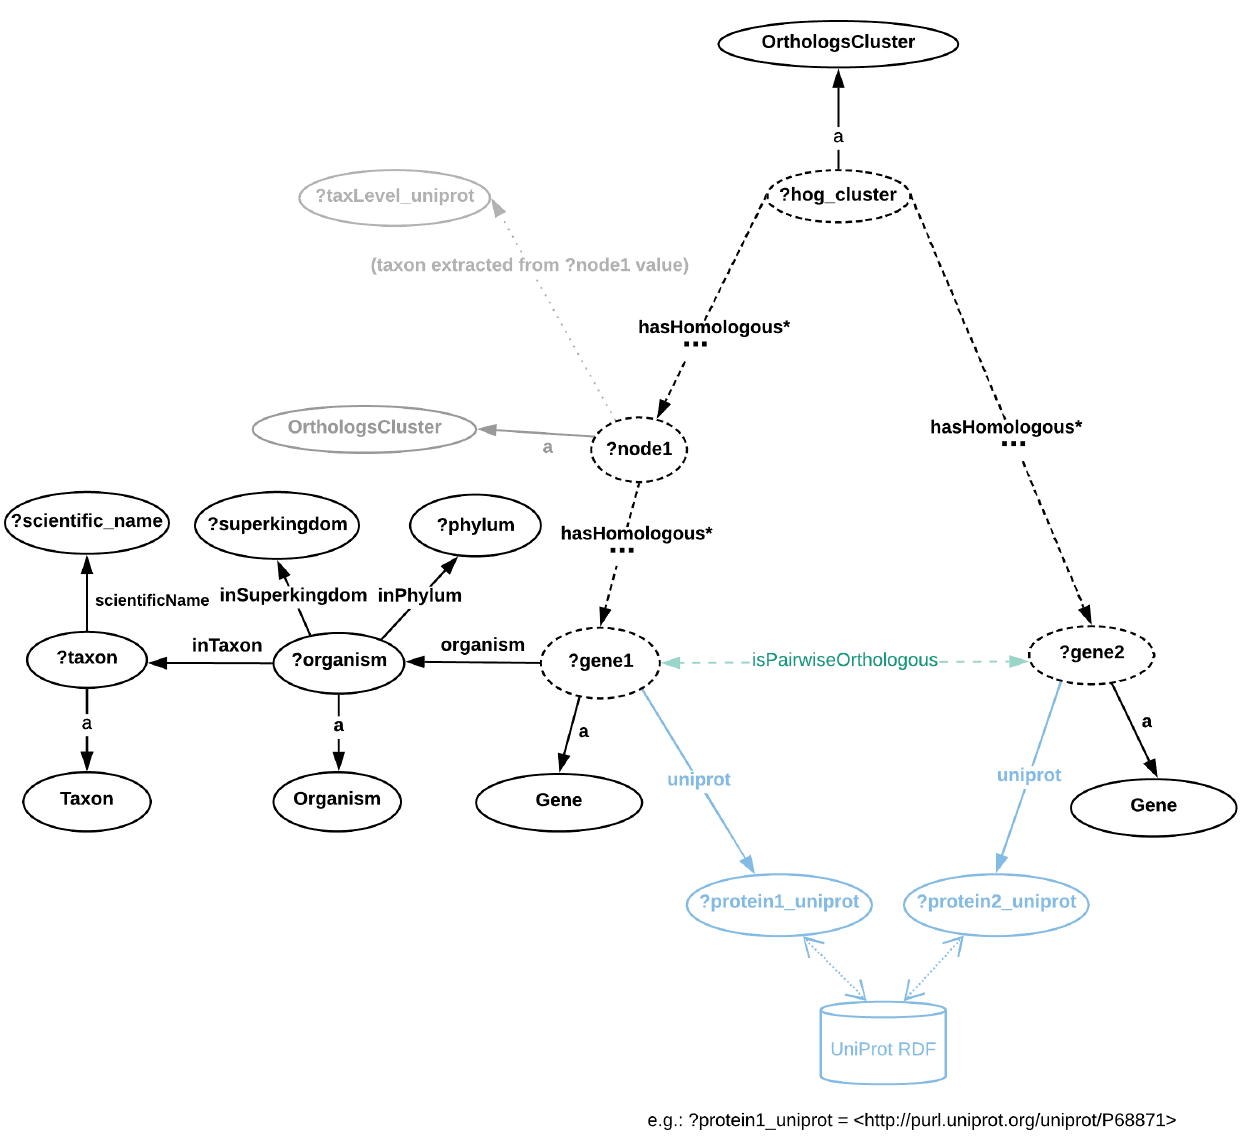
Figure 3. Directed graph abstraction of a portion of the MBGD RDF graph related to hierarchical orthologous groups. In Figure 3, nodes are either classes or variables, and edges are RDF properties. The terms preceded by a question mark (e.g. ?gene1 ) represent variables assigned with either zero or more literals or URIs. Dashed edges illustrate the orth:hasHomologous property that can be stated zero or more times, recursively. URI prefixes were omitted. MBGD is gene-centric and contains taxonomic ranges where HOGs are built are not directly available in RDF - in some cases these can be extracted from the cluster URI (e.g. http://mbgd.genome.ad.jp/rdf/resource/cluster/2018- 01_tax32_8537 corresponds to taxonomic identifier 32, Myxococcus). By contrast, the taxonomic information per gene entry is richer in ) MBGD than in OMA, including explicit Superkingdom and Phylum information. Example SPARQL queries based on this graph abstraction are provided in the “Protocols” section, as well as in the accompanying Jupyter notebook. The pairwise orthology information is not directly available (e.g. through an RDF property), but can be extracted from the Orthologs Cluster (to highlight this, the “isPairwiseOrthologous” is shown in green with a dashed